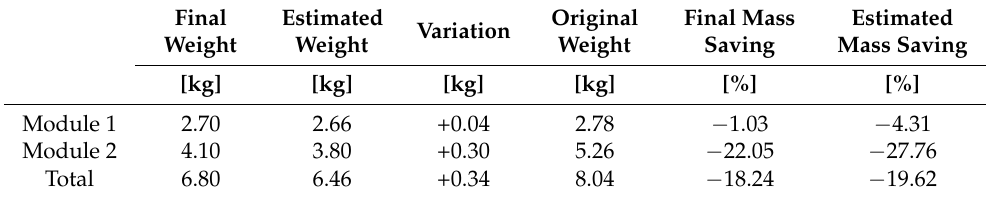
Table 9. Prototype mass